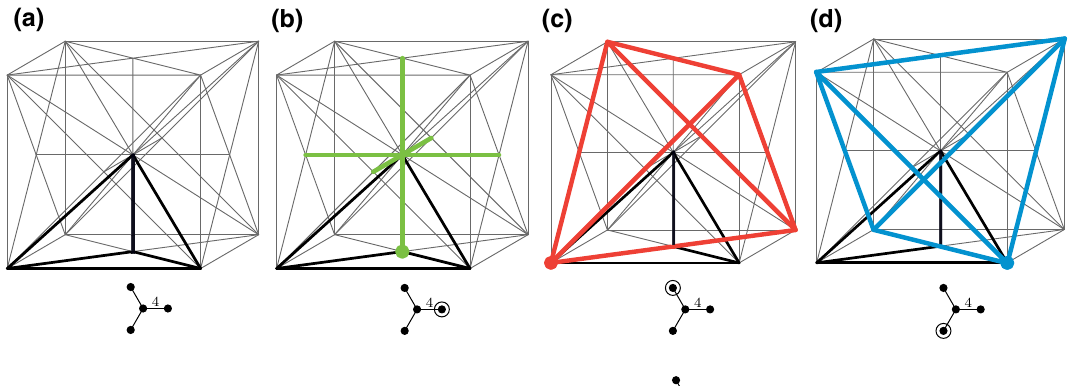
4 . (a) The fundamental region is the tetrahedron 4 produces a uniform tessel-